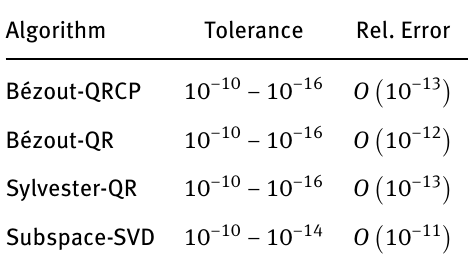
Table 2: Numerical relative error for the GCD of the set (24) in Example